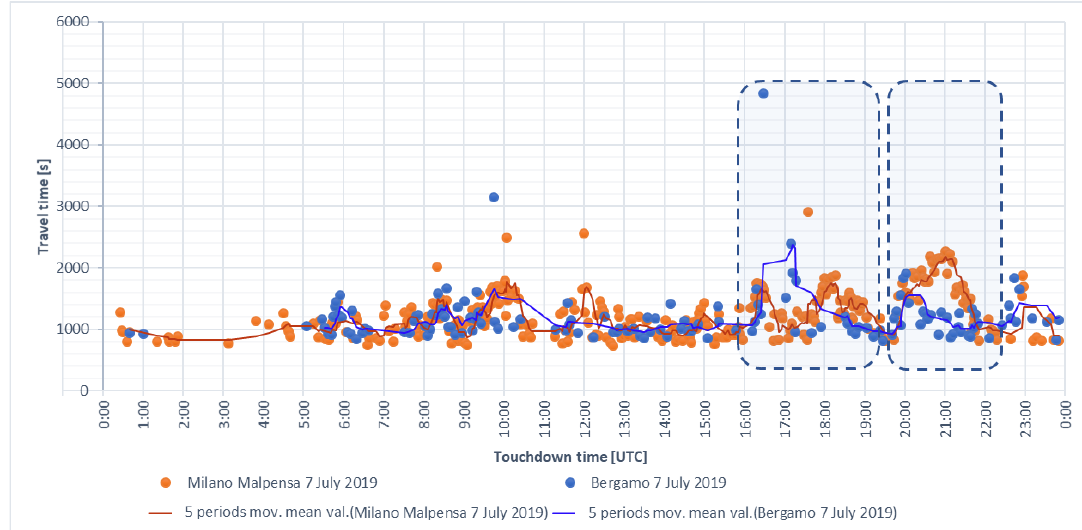
Figure 9. Visualization of travel time in the extended TMA and touchdown time for historical traffic at MXP (orange color) and at BGY (blue color) on 7 July 2019.